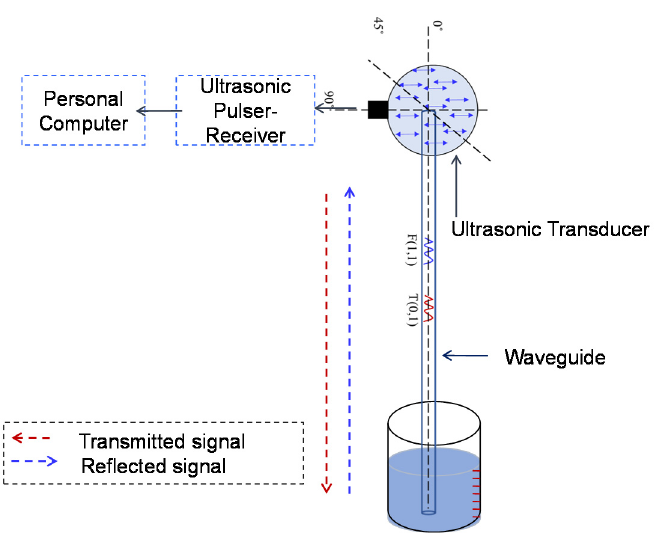
Figure 7. Experimental setup schematic for level measurement experiments.